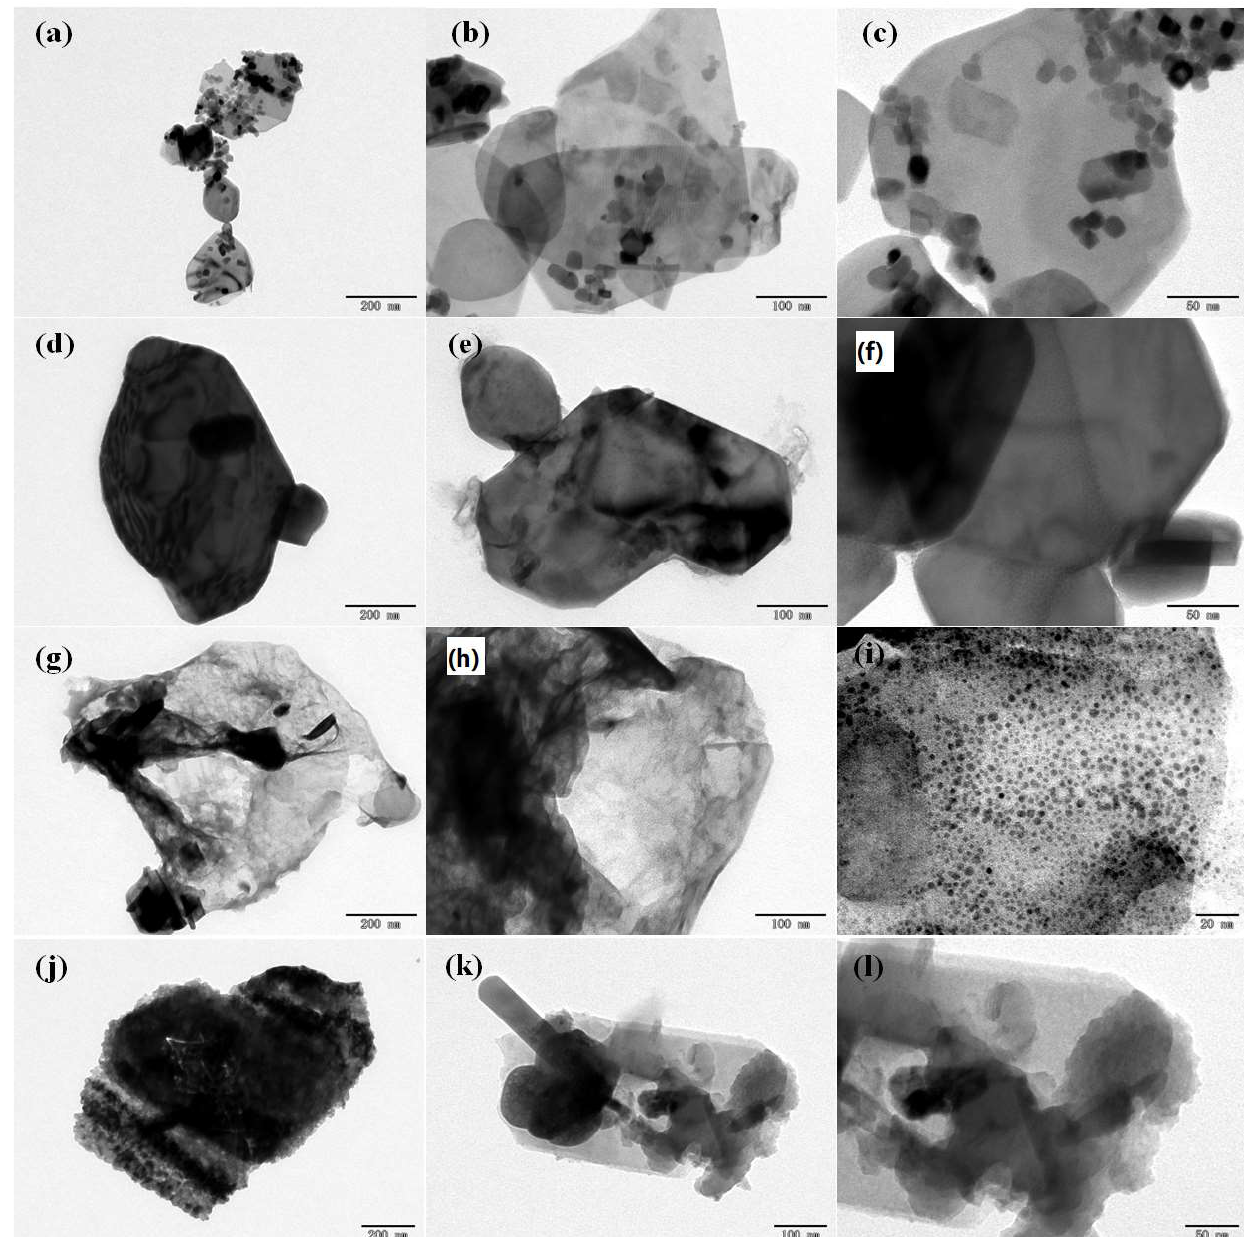
Figure 5. TEM results of all samples at different resolutions. ( a – c ) CP1 calcined at 700 ◦ C after leaching; ( d – f ) CP2 calcined at 800 ◦ C after leaching; ( g – i ) CP3 calcined at 600 ◦ C after leaching; ( j – l ) CP4 unprocessed waste cathode material calcined at 600 ◦